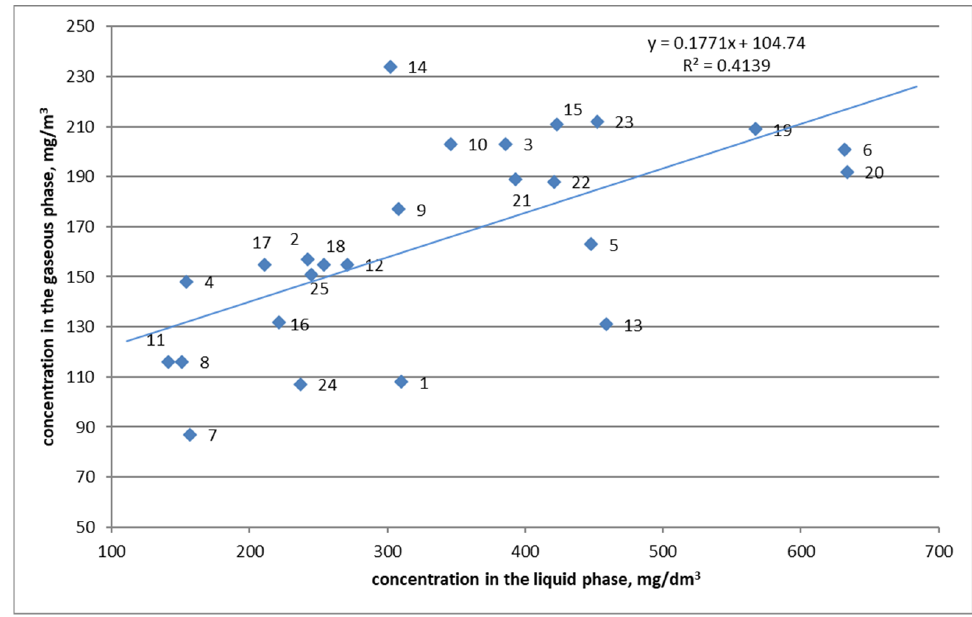
Figure 11. Concentration of toluene in the liquid and gaseous phases of diesel oil in equilibrium.